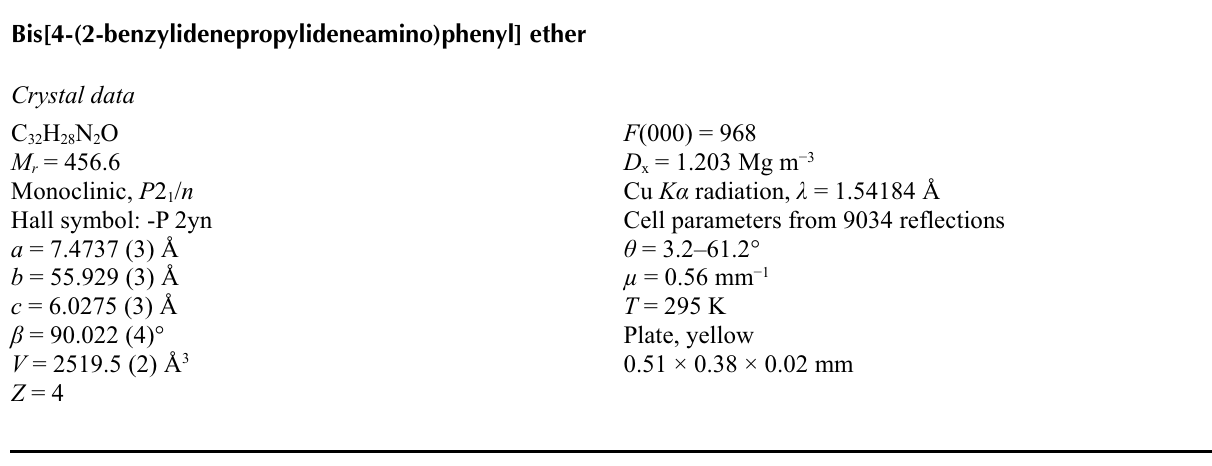
The packing of (I) viewed along c